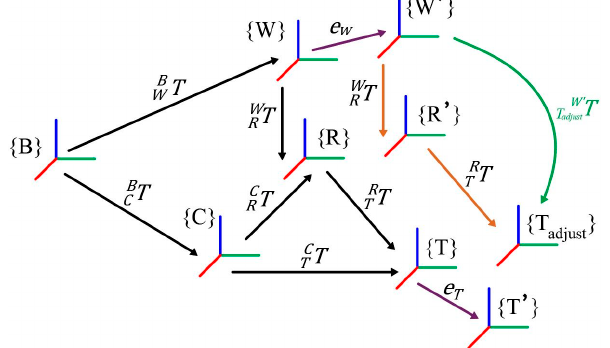
Figure 7. Error compensation in the process of attachment changing.